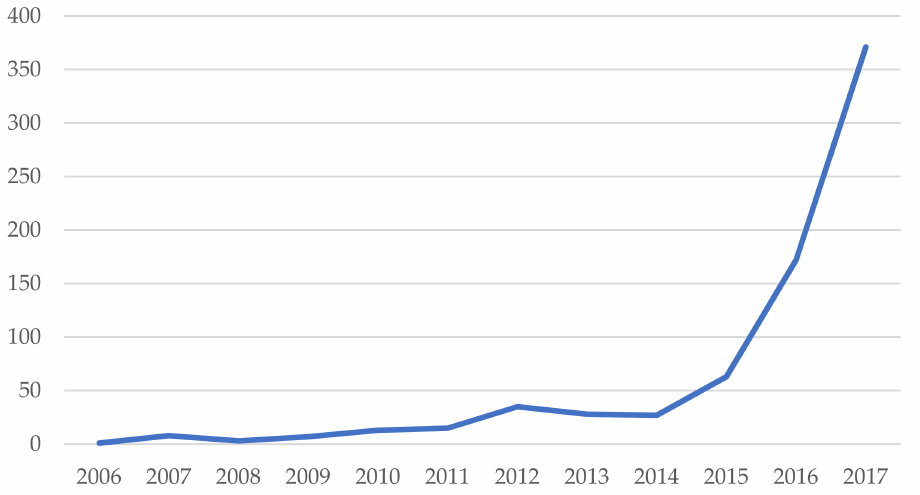
Figure 4. Annual evolution of publications.